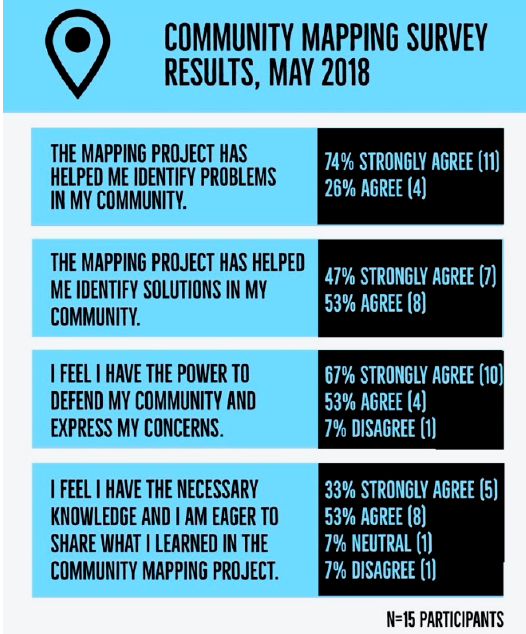
Figure 7. Community mapping survey results, May 2018.